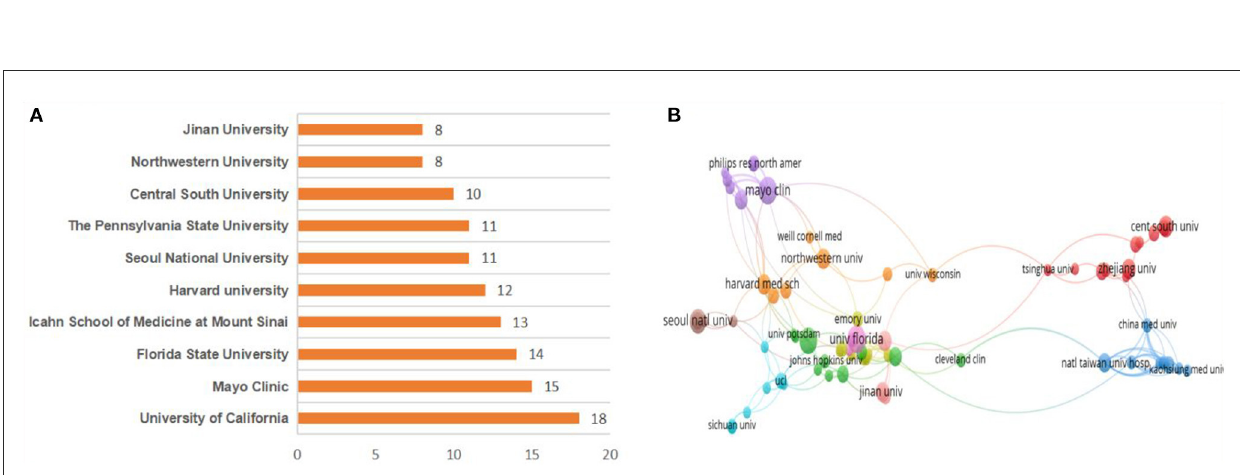
FIGURE4 (A) Top 10 institutions by publications. (B) Collaboration network of